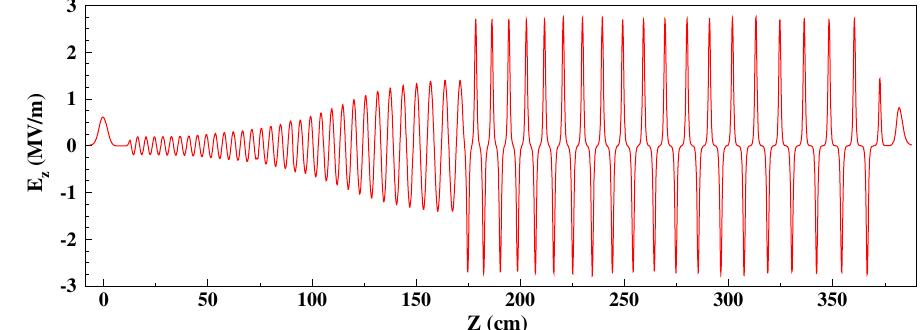
FIG. 2. On-axis longitudinal field along the RFQ.